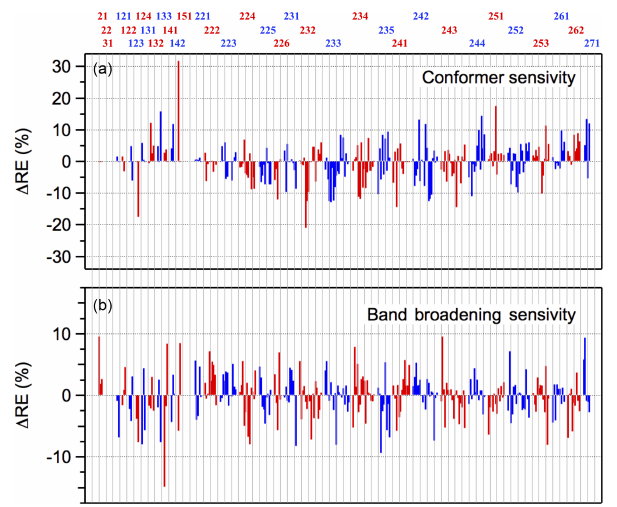
Figure 5. Sensitivity of the calculated HCFC radiative efficiencies in this study to (a) the inclusion of higher energy conformers and (b) to the broadening of the calculated infrared absorption bands, as described in the text. (cid:49) RE values are relative to the full analysis that includes broadened spectra and all conformers within 2kcalmole − 1 of lowest energy